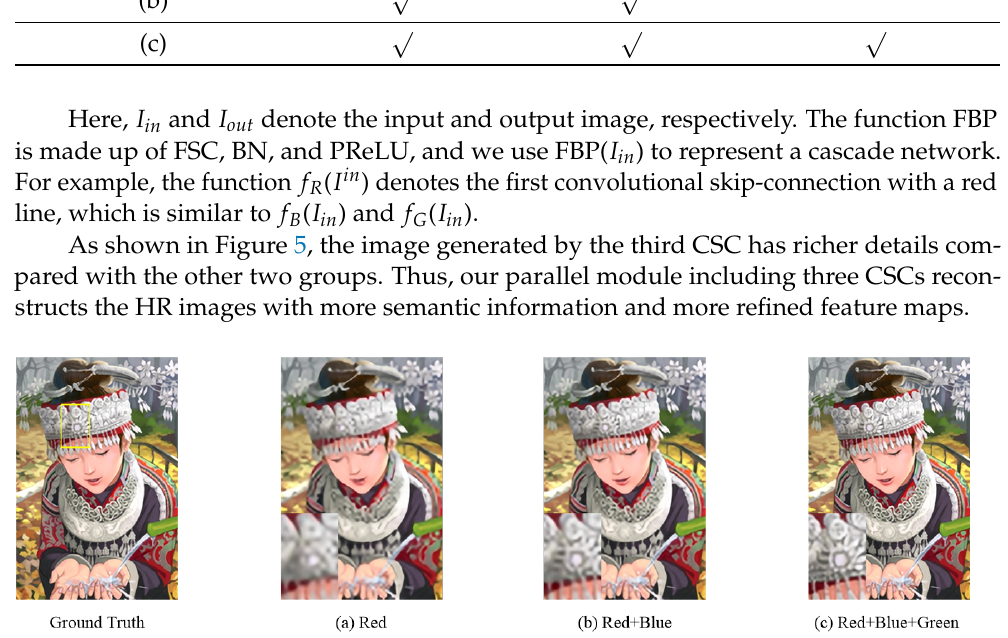
Figure 5. Visual comparison with different inputs on the convolutional skip connections. ( a ) The generative network has only red convolutional skip-connections. ( b ) There are 2 convolutional skip-connections, including red and blue, in the generative network. ( c ) Our generative network is a parallel architecture, which contains red, blue, and green convolutional